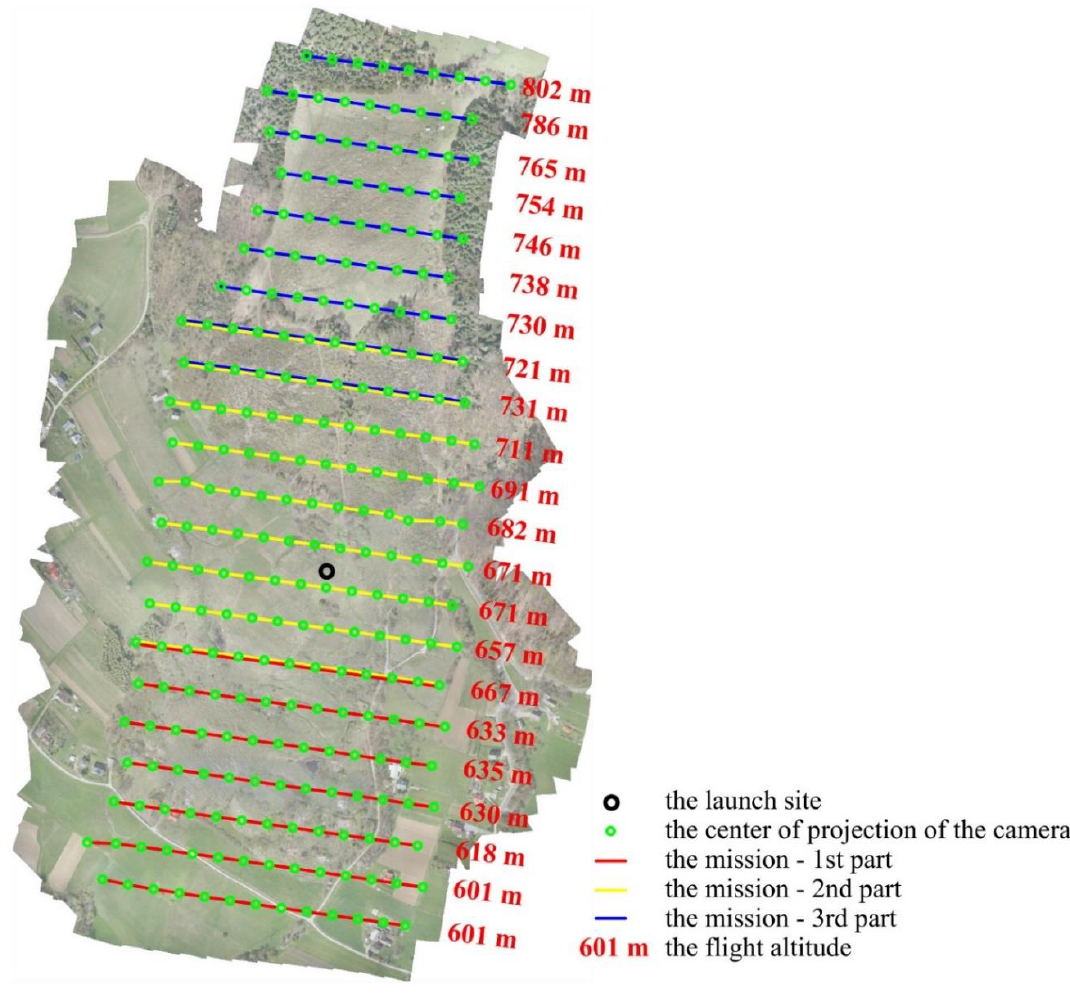
Figure 4. Plan of photogrammetric flight over the landslide.